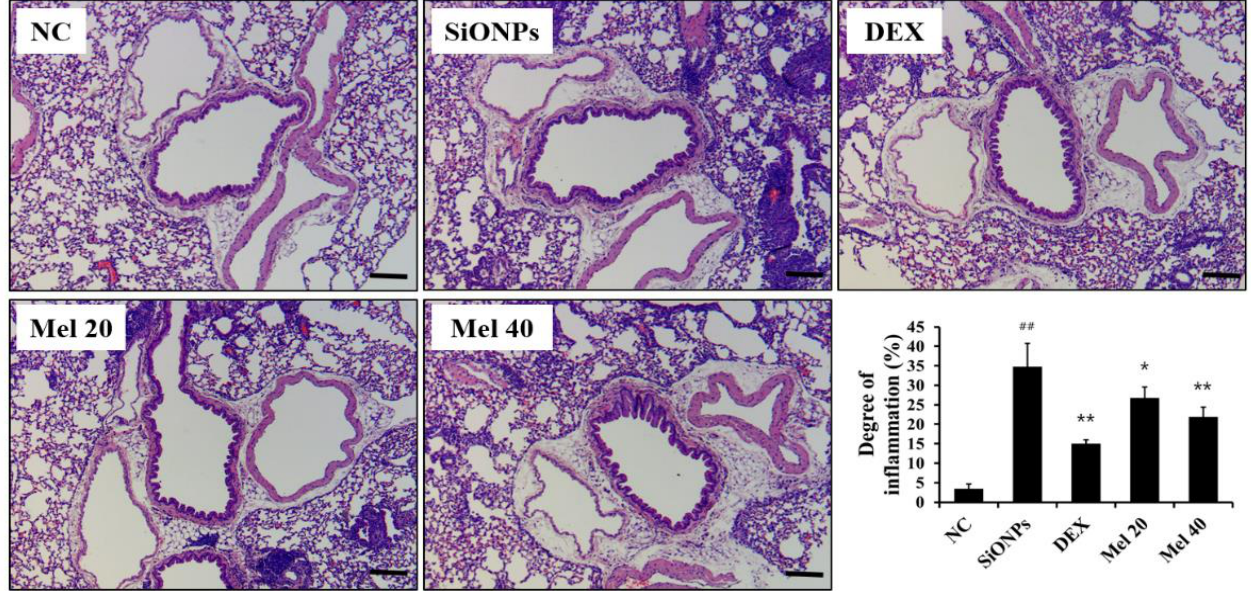
Figure 3. Melatonin ameliorated inflammatory responses in the respiratory tract of SiONPs-exposed mice. Lung tissue was stained with H&E stain to assess airway inflammation (magnification: x200). Degree of inflammation was quantified using image analyzer (IMT i-Solution). Scale bars = 50 µ m. ## p < 0.01, vs. the NC; * p < 0.05, ** p < 0.01, vs. the